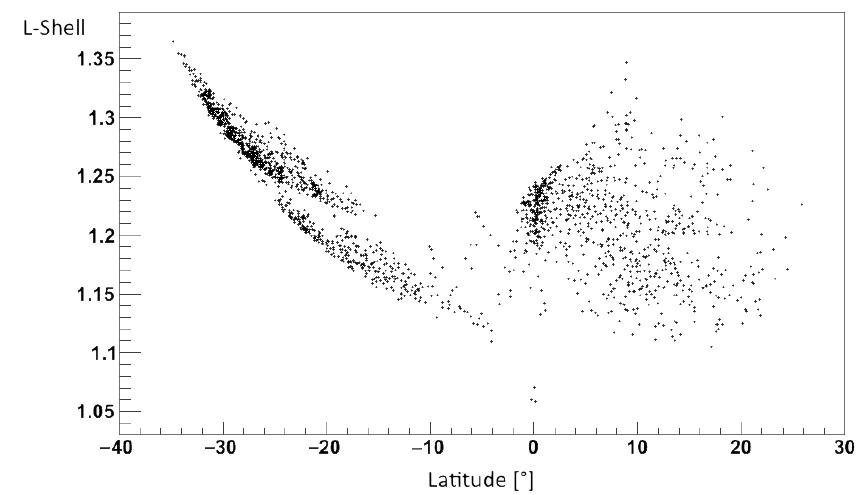
Figure 3. The L-shell parameter distribution is compared to the EB latitudes; the distribution pattern is different from those of the EB correlation with West Pacific EQs as in this case EB longitudes correspond to the SAA.